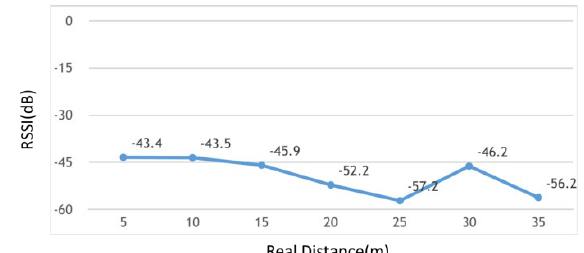
Figure 2. Average RSSI decay over distance of 35 m from AP in Figure 1(a)